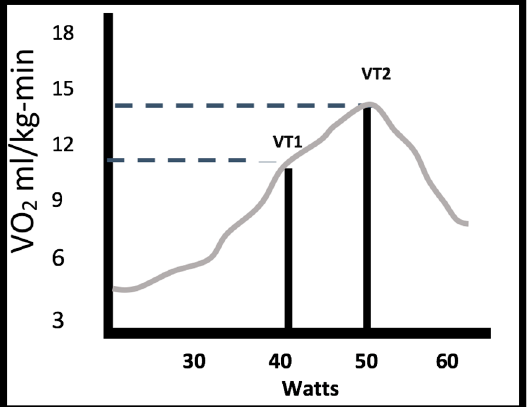
Figure 2. Watts and oxygen consumption (VO 2 ) at first and second thresholds (VT1 with a VO 2 of 11.08 mL/kg-min and 40 watts; VT2 with a VO 2 of 13.9 mL/kg-min and 60 watts). Table 2. Average result of the submaximal variables measured, with their mean and standard deviation.